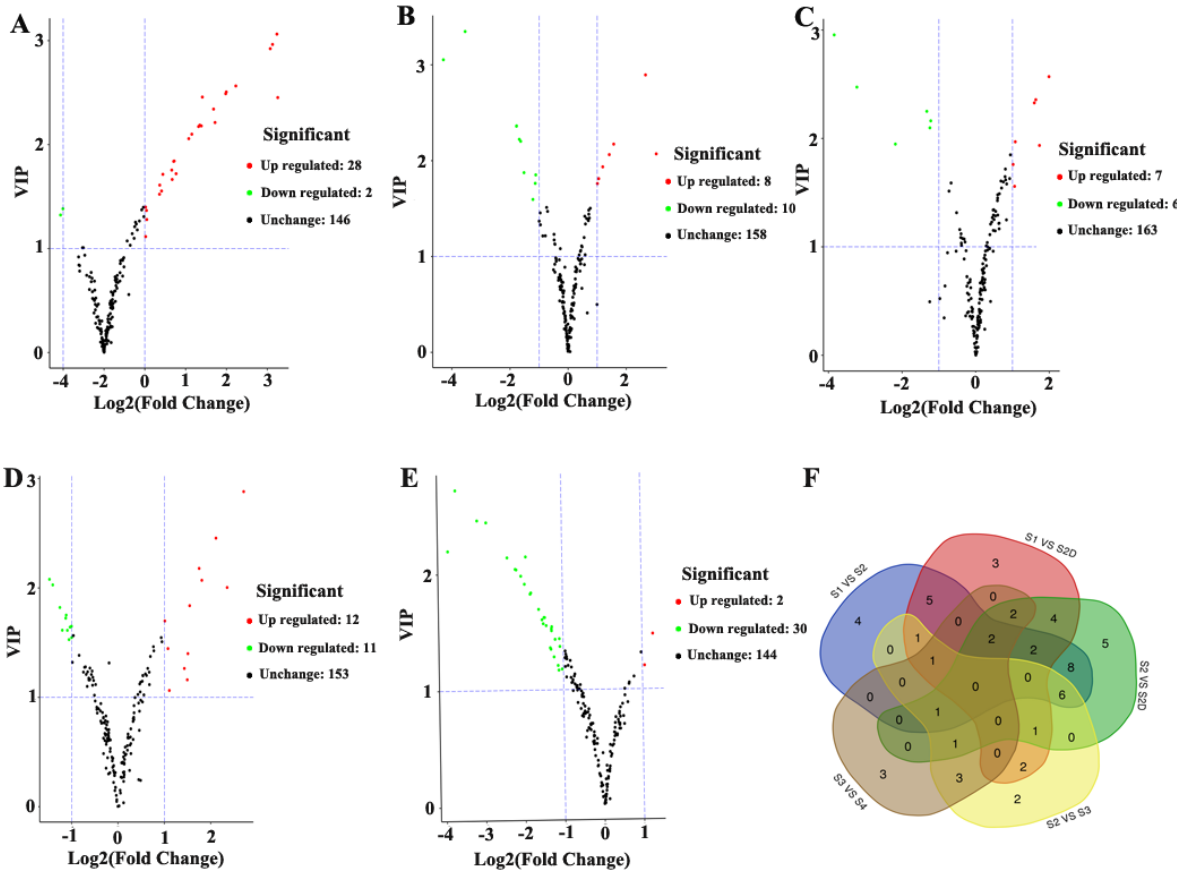
Figure 4. Differential flavonoid metabolites screening results for each comparison group by volcano plots (( A ), S1 versus S2; ( B ), S2 versus S3; ( C ), S3 versus S4; ( D ), S1 versus S1D and ( E ), S2 versus S2D), and Venn diagram of these five comparison groups ( F ).